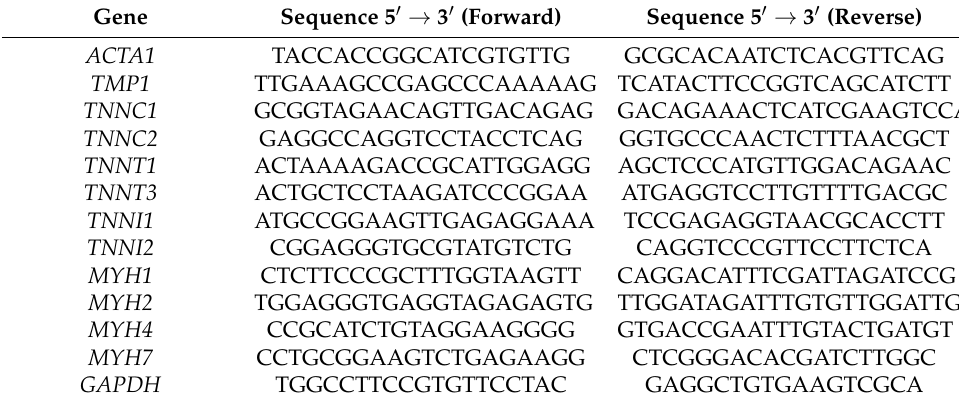
Table 1. List of primer sequences for RT-qPCR.